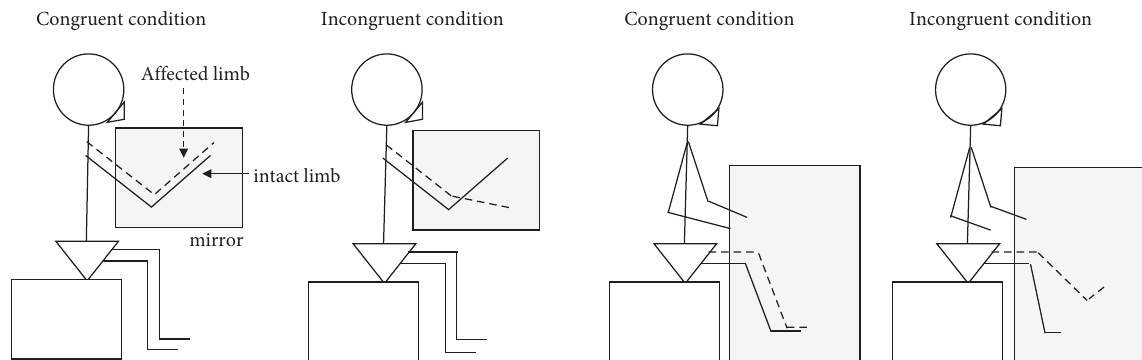
Figure 1: Te patient was seated in a chair and a mirror (150cm × 90cm) was placed between the upper or lower extremities in the congruent and incongruent conditions. Congruent condition: the patient performed fexion-extension exercises on the healthy and afected sides at the same time. Incongruent condition: the patient performed fexion-extension exercises on the healthy and afected sides at diferent times. Each condition was performed for